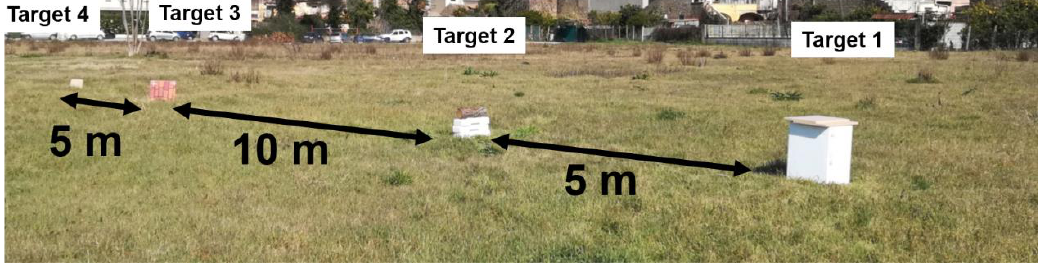
Figure 13. Second Test Case: radar imaging scenario.